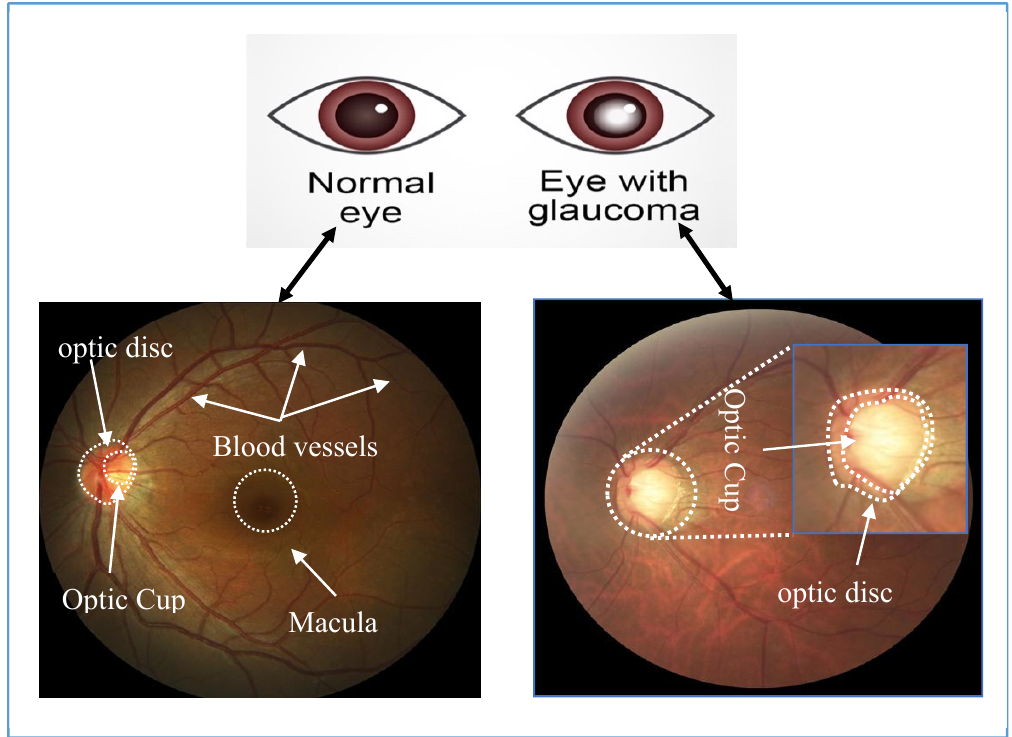
Figure 1. Images of a healthy retina (left) and one with glaucoma (right).